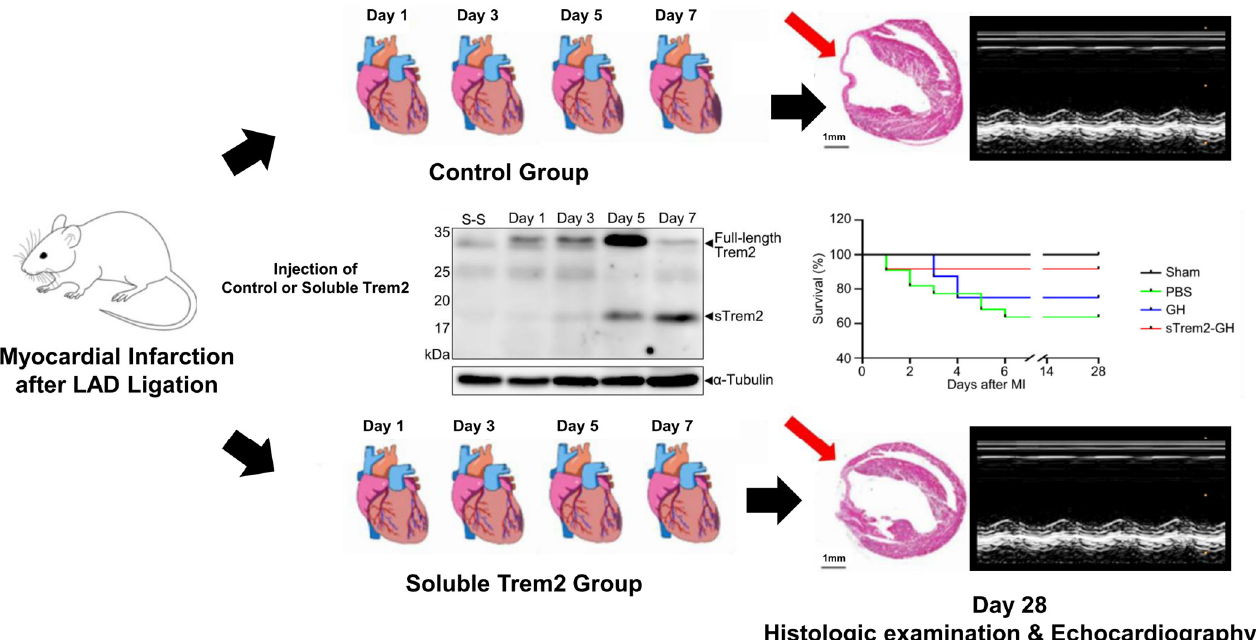
Figure 4. In vivo function of soluble Trem2 in mouse hearts after MI [10]. Left ventricle function and survival following myocardial infarction were assessed, comparing the effect of sTrem2. Mice with ligated left anterior descending arteries were injected with either control or sTrem2 molecule. Echocardiographic left ventricle function and histologic infarct size were compared 28 days post-MI, showing a smaller infarct size and better echocardiographic function in sTrem2 group; 28 days survival was superior in sTrem2-injected group.